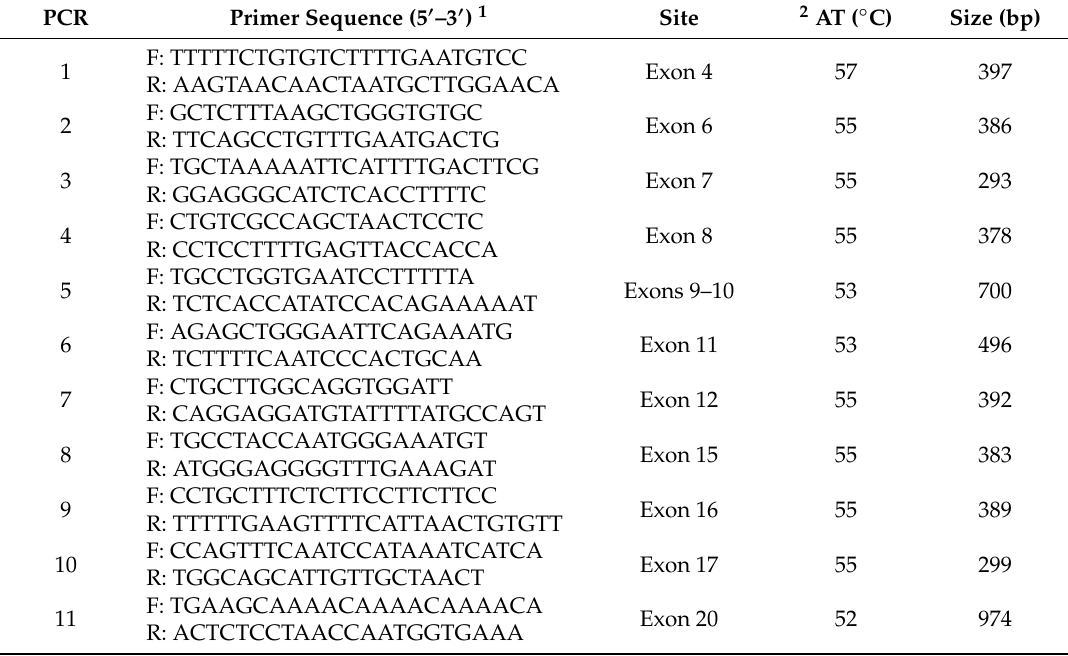
Table 1. Primer sequences, location, annealing temperatures and amplification fragment